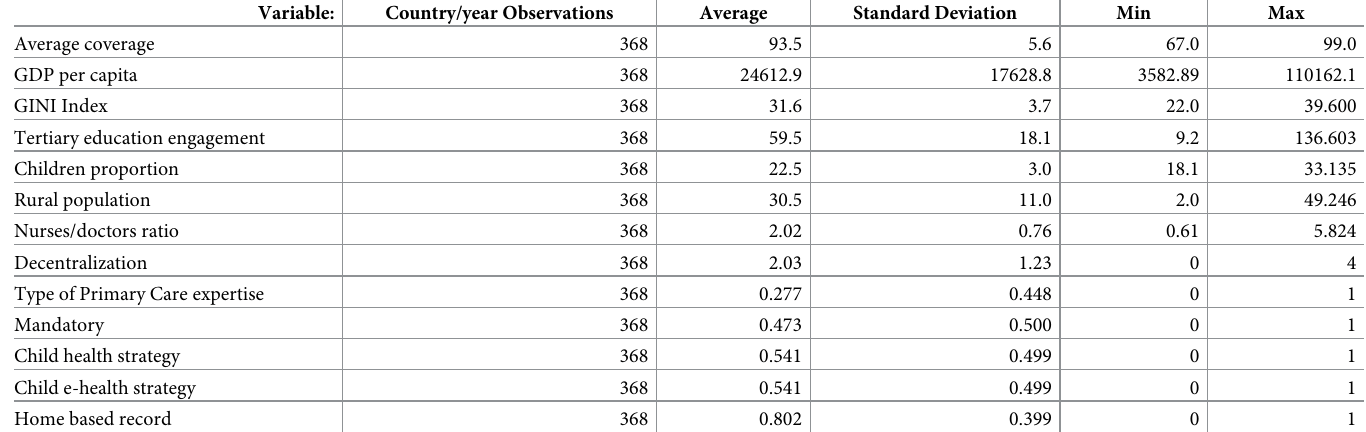
Table 3. Summary statistics of the variables adopted in the econometric analysis reporting the number of observations, the average and standard deviation as well as the minimum and maximum values. Variable: